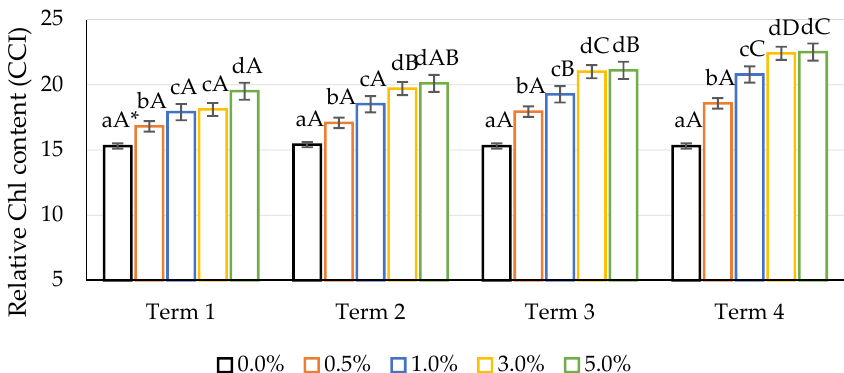
Figure 4. Impact of different aqueous concentrations of potassium quercetin derivative on relative Chl content (CCI) in maize leaves. * Lowercase letters indicate significant differences between the means on respective measurement times, and capital letters indicate significant differences between means on the measurement times for respective potassium quercetin derivative concentrations and exposure times ( n = 30, p < 0.05).